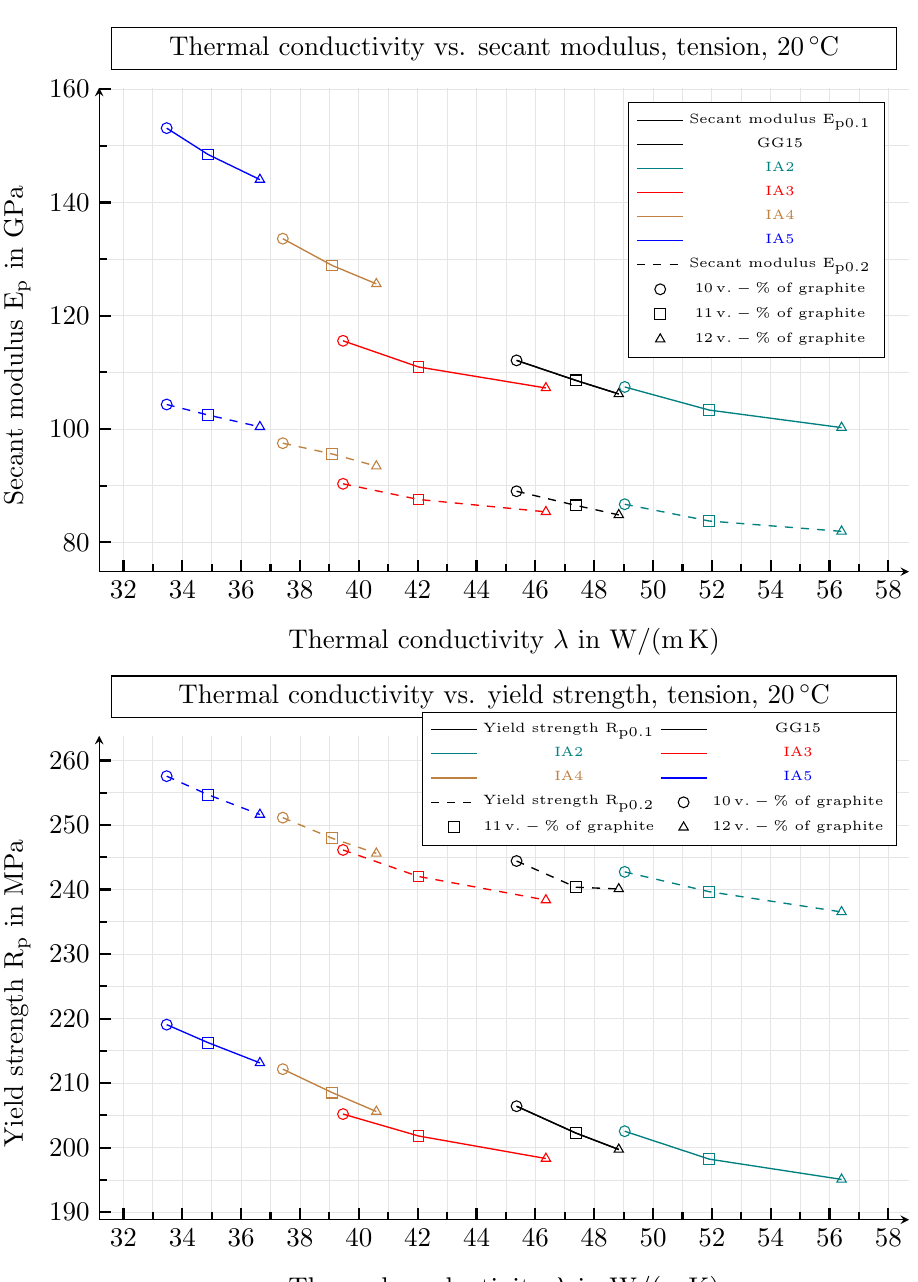
Figure 31. Secand moduli and yield strengths vs. thermal conductivities of all graphite classes with graphite flake volume fractions of 10, 11 and 12v. tensile load for strains of ε = 0.1% and ε =